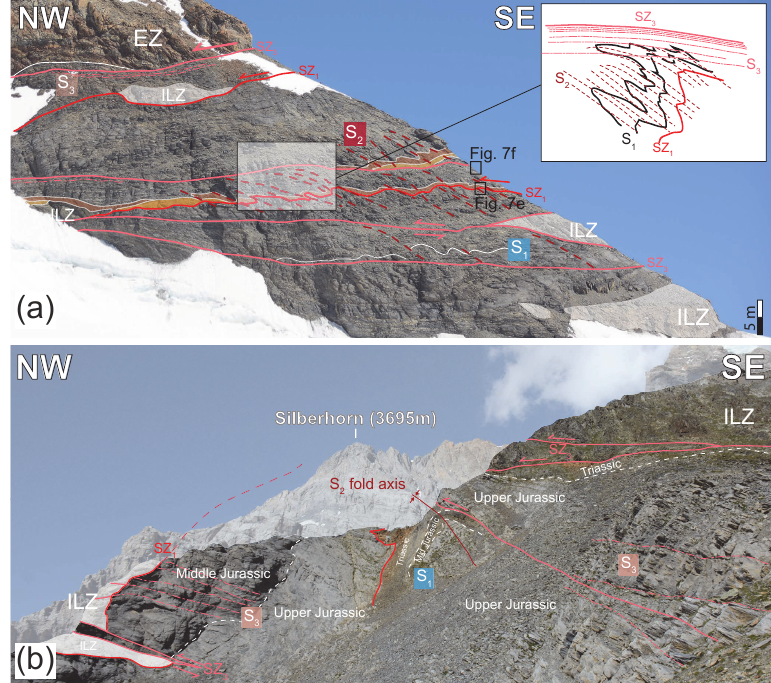
Figure 10. Cross-cutting and overprinting relations between the structures close to the basement cover contact for key locations. (a) Sed- iments in the Jungfrau sediment wedge (JSW), at the Mönchsjoch locality (MJ; see Figs. 2, 9), between the Erstfeld zone (EZ) and the Innertkirchen–Lauterbrunnen zone (ILZ) illustrating the cross-cutting and overprinting (see also insert). Note that some sediment markers are highlighted (brown: Middle Jurassic, orange: Triassic). (b) Similar structures at the Rottal (RT; see Figs. 2, 9) location, where the late thrusting of the ILZ basement caused deflection and rotation of the S2 folds and cross-cutting and passive rotation of the SZ1 thrusts. Note the penetrative S3 foliation.